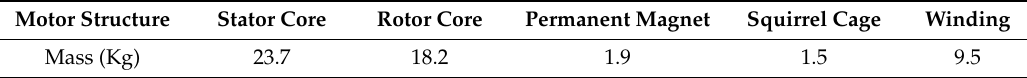
Figure 2. The platform for motor testing. Table 3. Material masses of each component of the